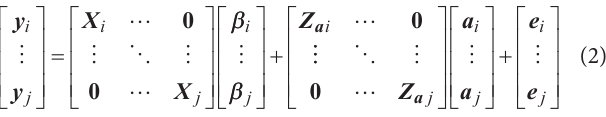
Metrics are grouped as being point based, shape based, or voxel